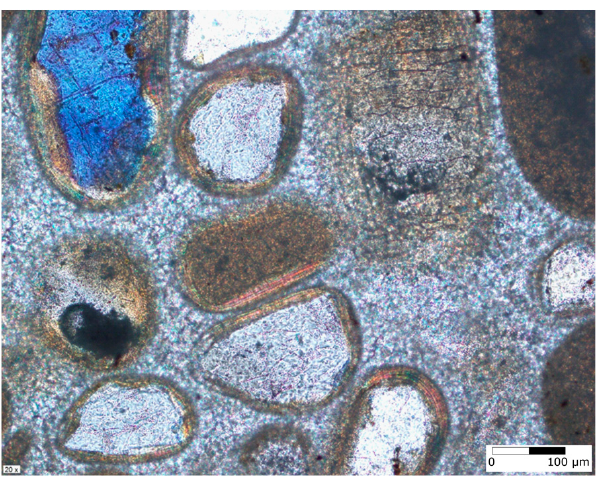
Figure 3. Petrographic slide showing the rounded ooids found in Core A (Figure